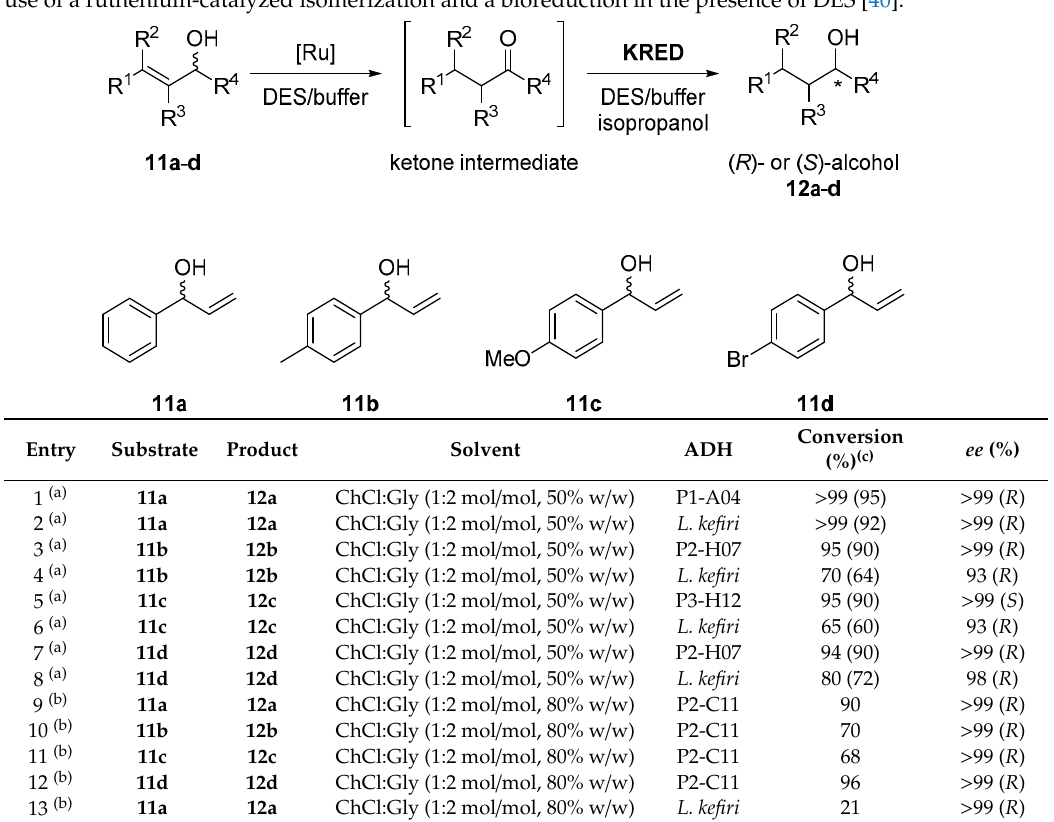
Table 3. The conversion and enantiomeric excess results of a sequential process reaction combining the use of a ruthenium-catalyzed isomerization and a bioreduction in the presence of DES